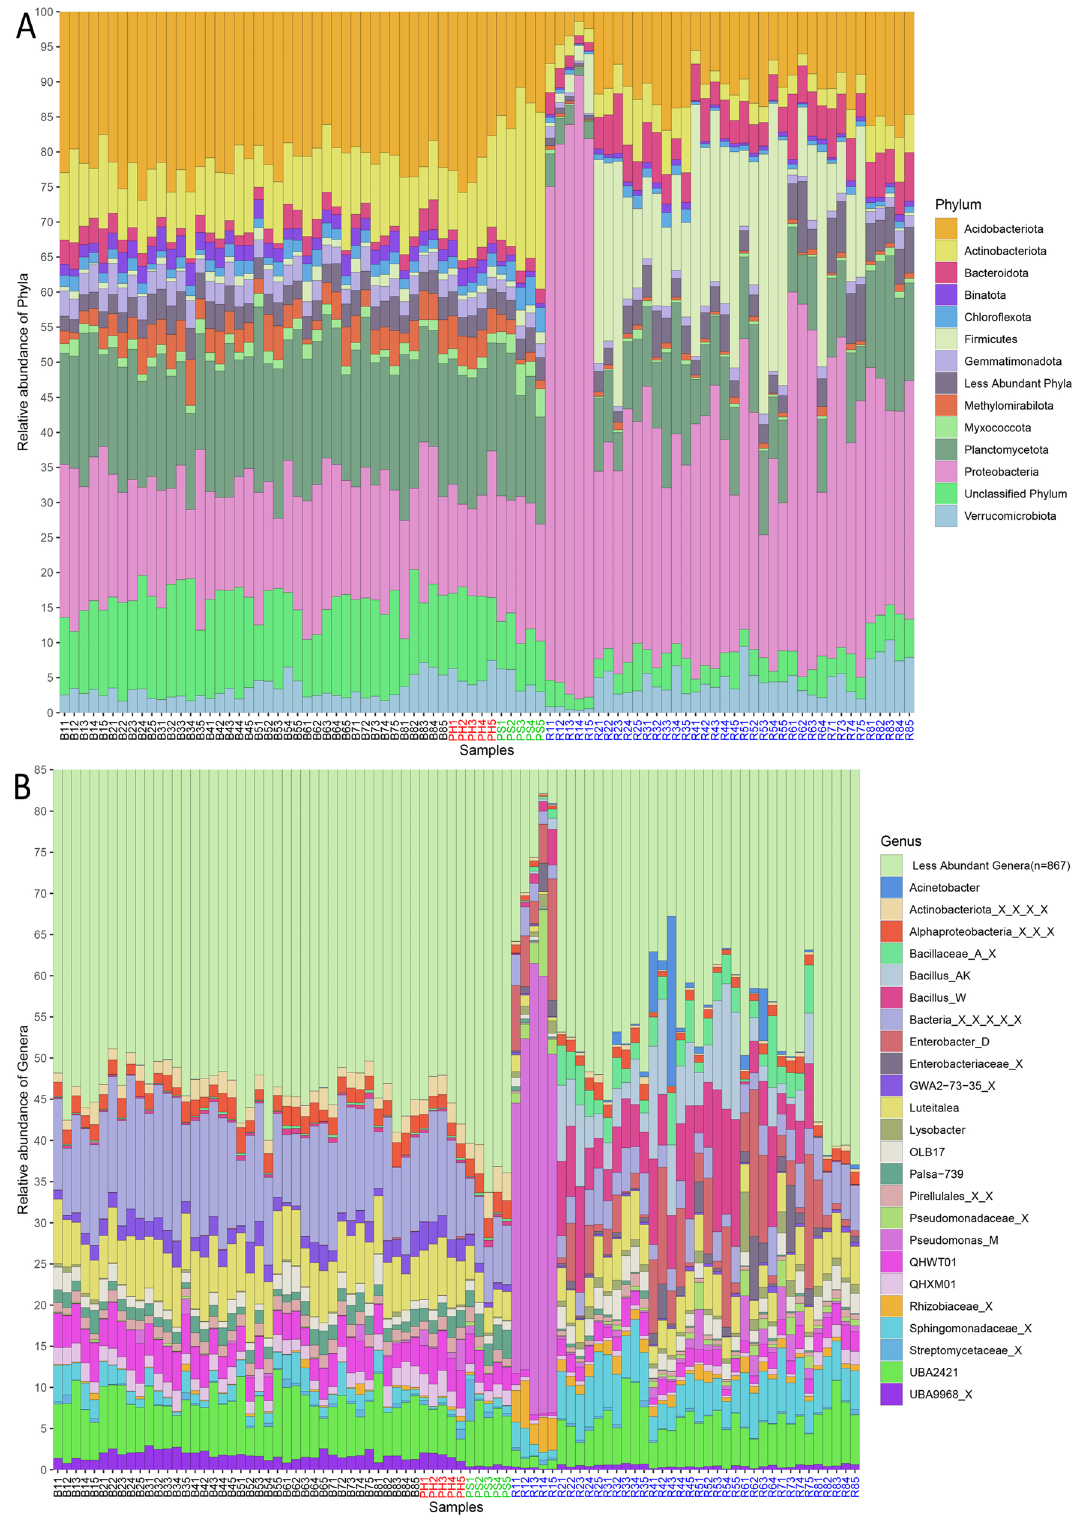
Figure 2. Taxonomic distribution at ( A ) phylum level and ( B ) Genus level. Only the top taxa are plotted for both levels. Sample names are coloured by type of